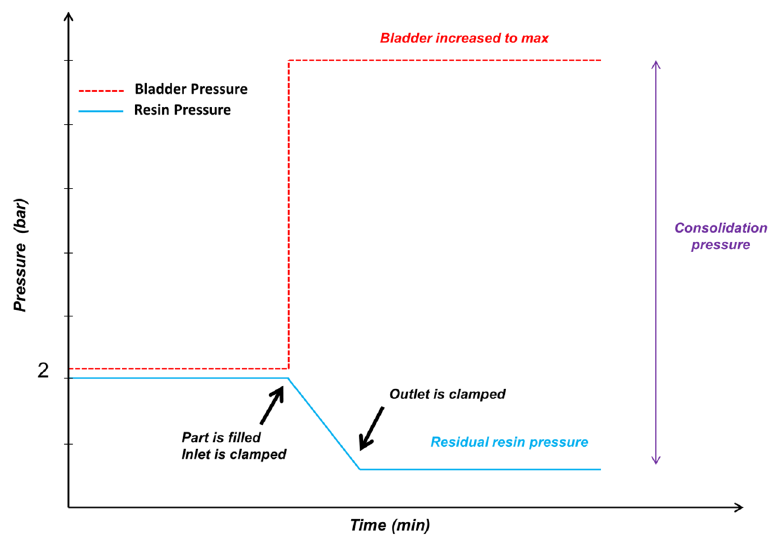
Figure 17. Deduced scheme for injecting a thin-ply tubular section with optimized parameters and boundary